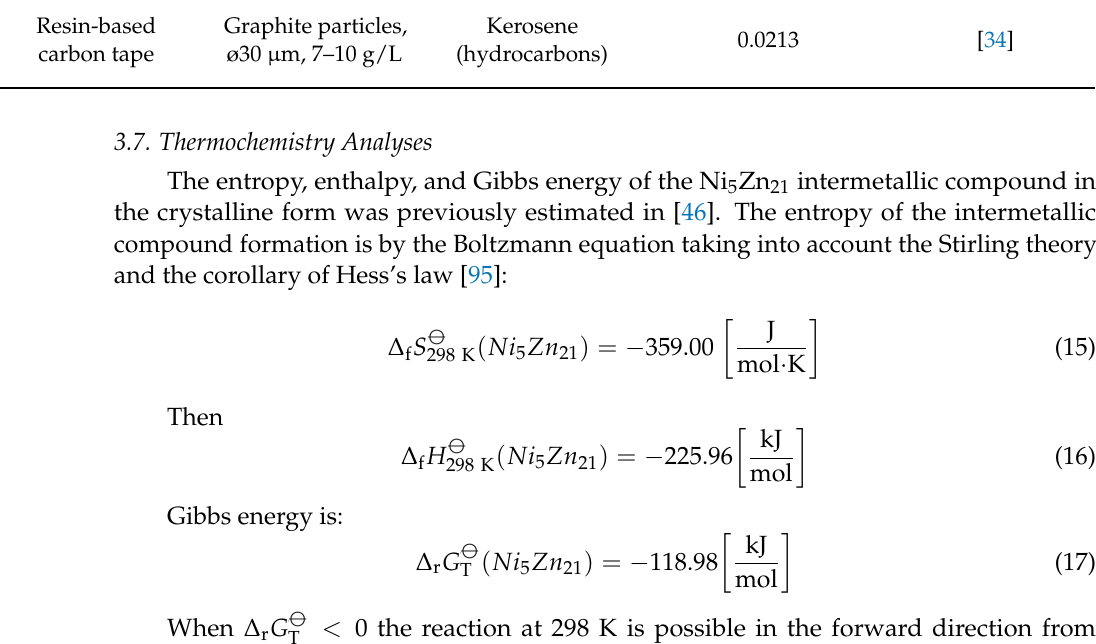
Table 14. Calculated enthalpy of formation of some Ni-containing substances.